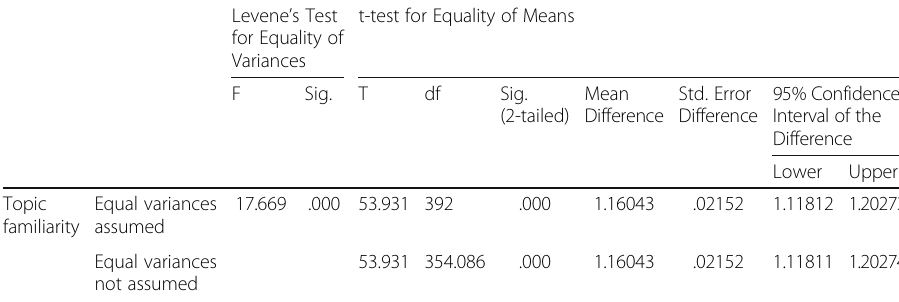
Table 10 The Results of T-Test To Compare the Results of Learners ’ Perception of Textbook- Assigned and Self-Selected Topics Regarding Topic Familiarity Levene ’ s Test t-test for Equality of Means for Equality of Variances F Sig. T df Sig. Mean Std. Error 95% Confidence (2-tailed) Difference Difference Interval of the Difference Lower Upper Topic Equal variances familiarity